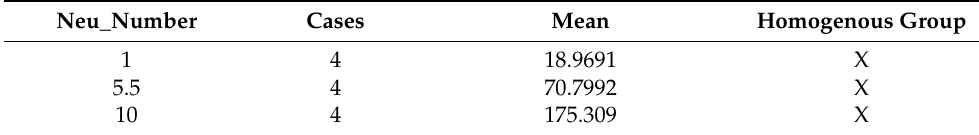
Table 14. Fisher LSD test.